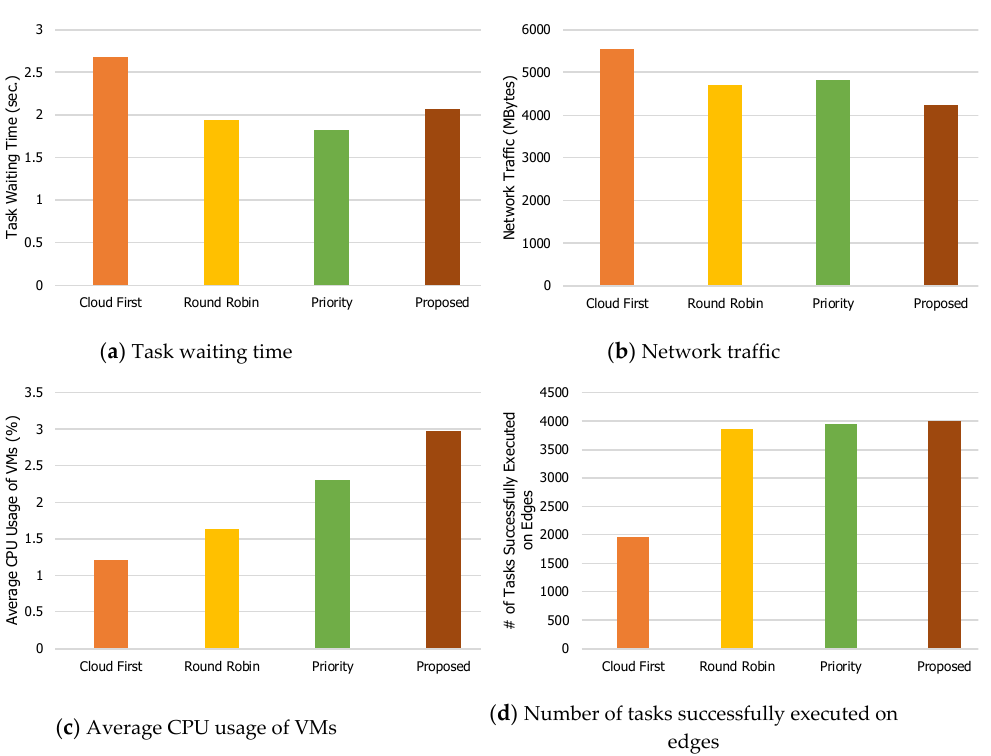
Figure 7. Performance comparisons when the number of mobile devices is 800.